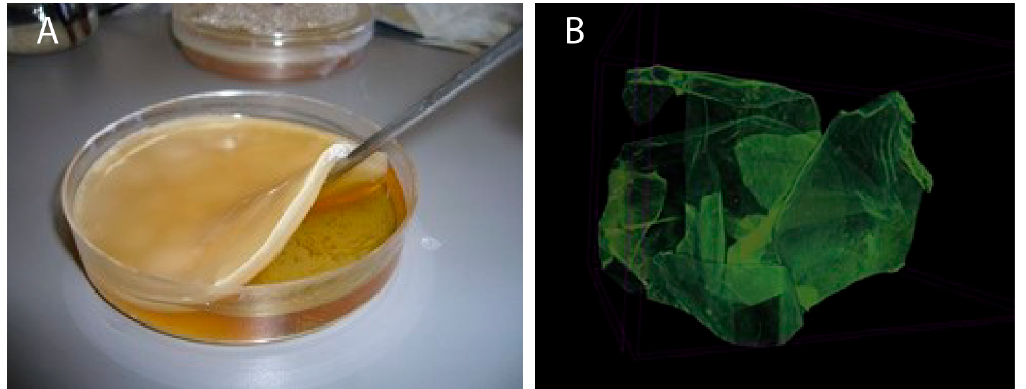
Figure 1. Optical and µCT images. ( A ) Optical photograph of BC nanofibres; ( B ) µCT image of BC nanofibres.